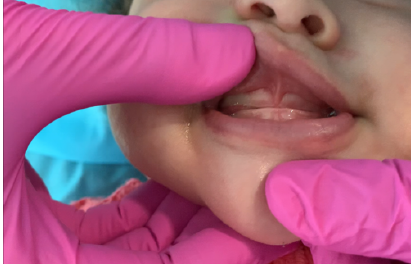
Figure 1. The infant had gingival rounds in inverted relation. Photograph was taken with the patient asleep.